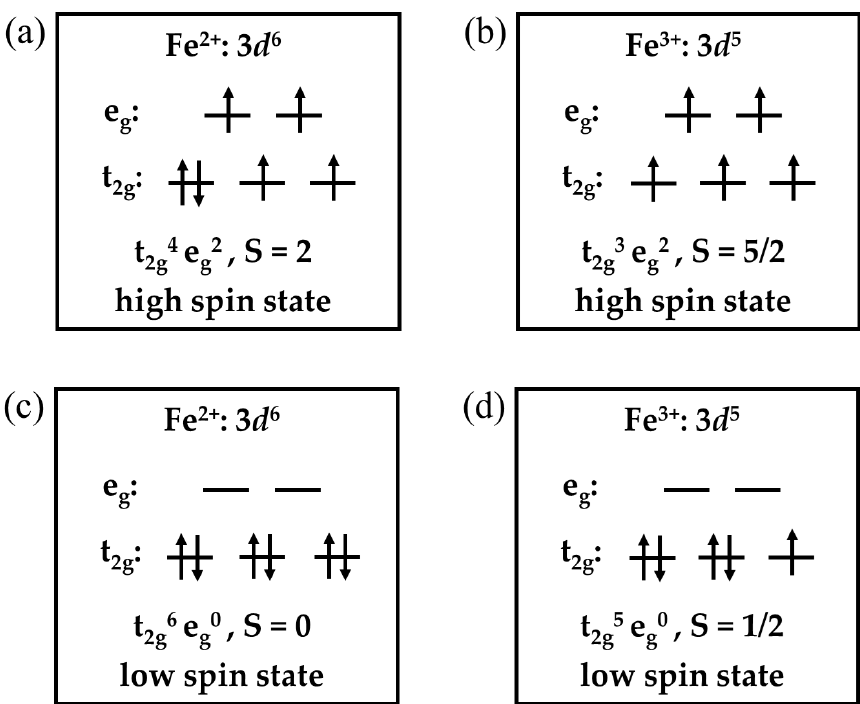
Figure 1. The arrangement of 3 d electrons in high-spin state ( a , b ) and low-spin state ( c , d ) of F e 2+ and Fe 3+ . A common EPR spectrometer consists of a microwave bridge, microwave source, magnetic field, resonator, and other components. The commonly used microwave bands are: X-band (~9.5 GHz), K-band (~24 GHz), Q-band (~35 GHz), and W-band (~94 GHz). In general, the waveguide and resonator sizes of the most widely used X-band instruments are suitable for polycrystalline, solution, or powder samples. The resonator of the Q-band instrument is smaller, and the filling coefficient of the sample in the cavity is larger. Thus, it is suitable for small single-crystal samples. It is noteworthy, one of the advantages of the Q-band instrument is that the required amount of cold liquid (such as liquid